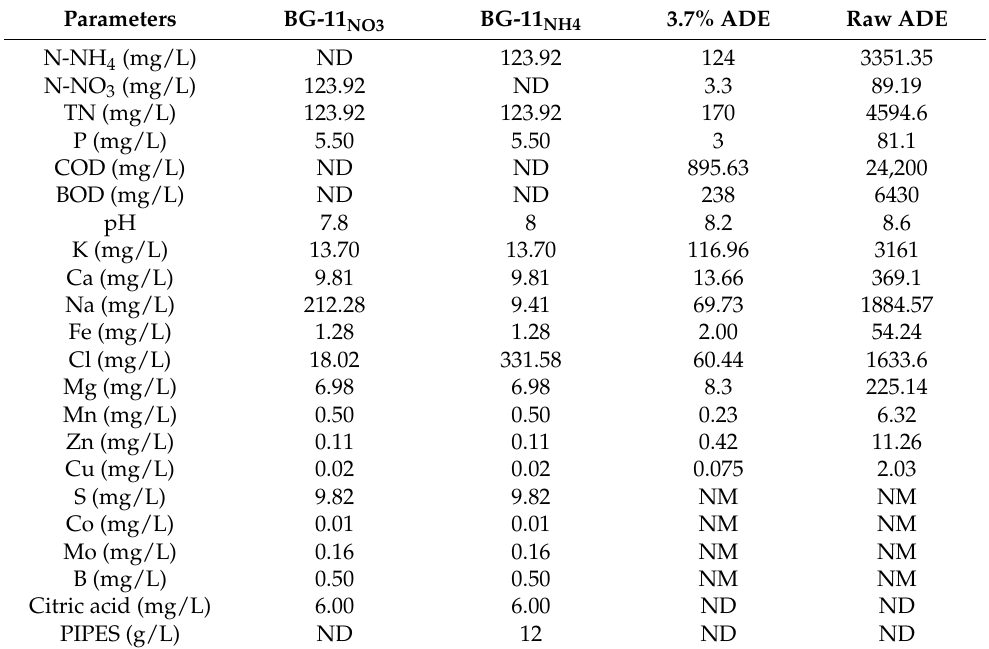
Table 1. Physicochemical composition of raw